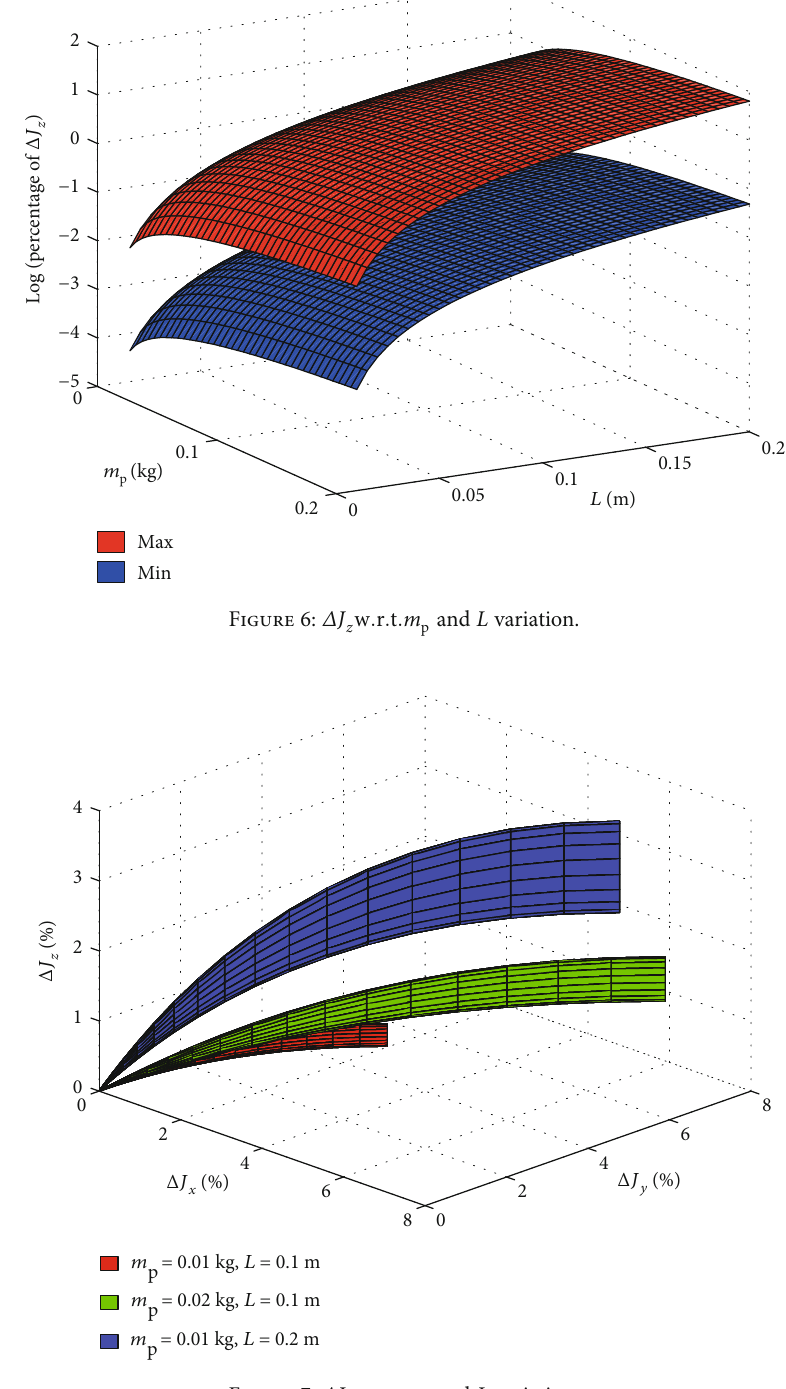
w : r : t : m and L p k